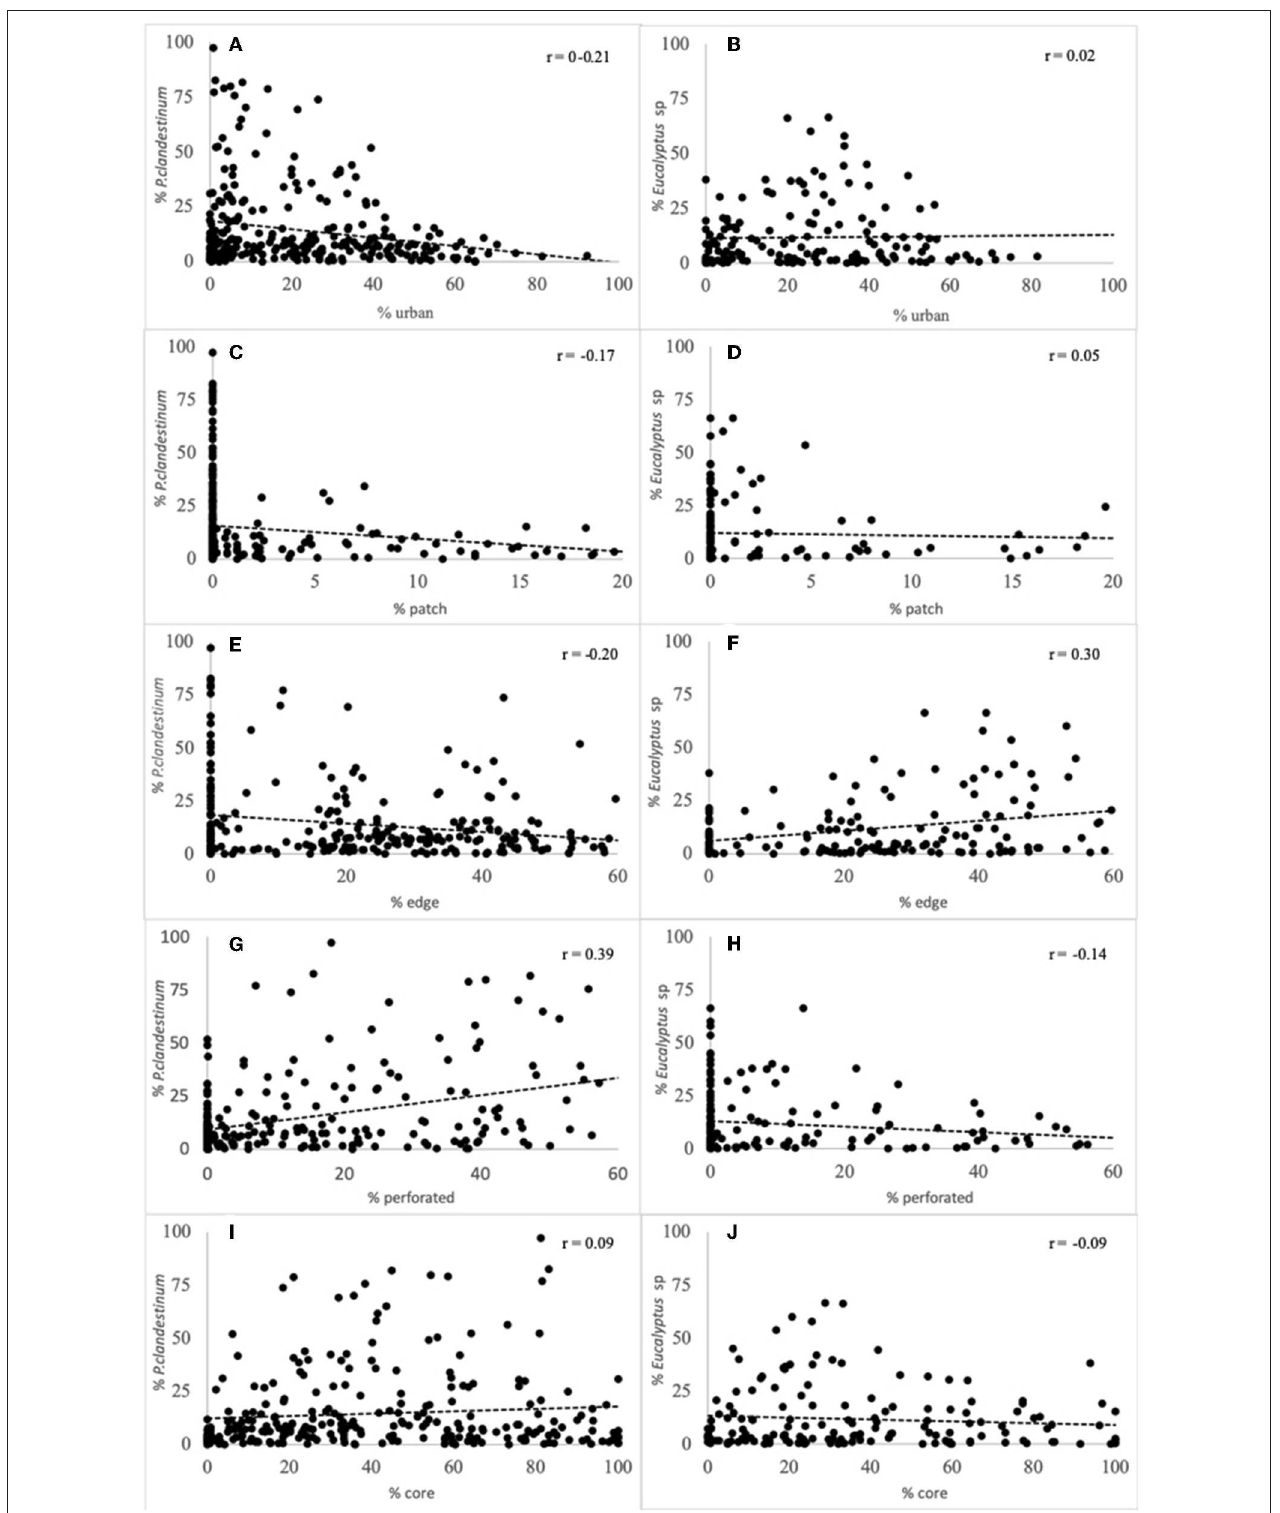
FIGURE 7 | Percent cover of Pennisetum clandestinum (A,C,E,G,I) and Eucalyptus spp. (B,D,F,H,J) compared to % urban land cover, and % patch, edge, perforated, and core fragmentation categories in each 1-ha unit.